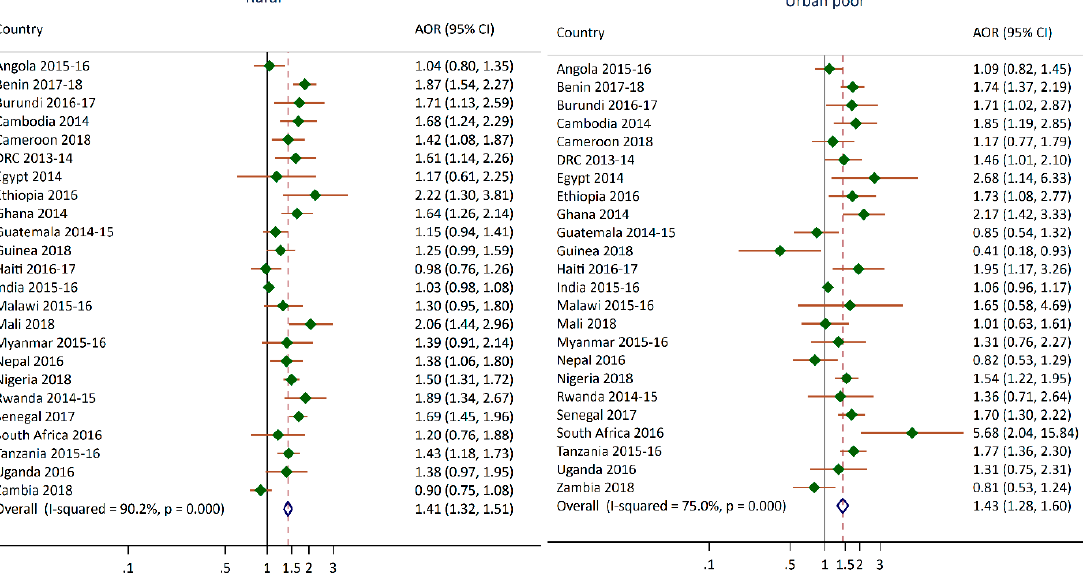
Figure 3. Adjusted odds ratios of moderate or severe anemia for children living in urban poor and rural clusters compared to children living in urban non-poor clusters.